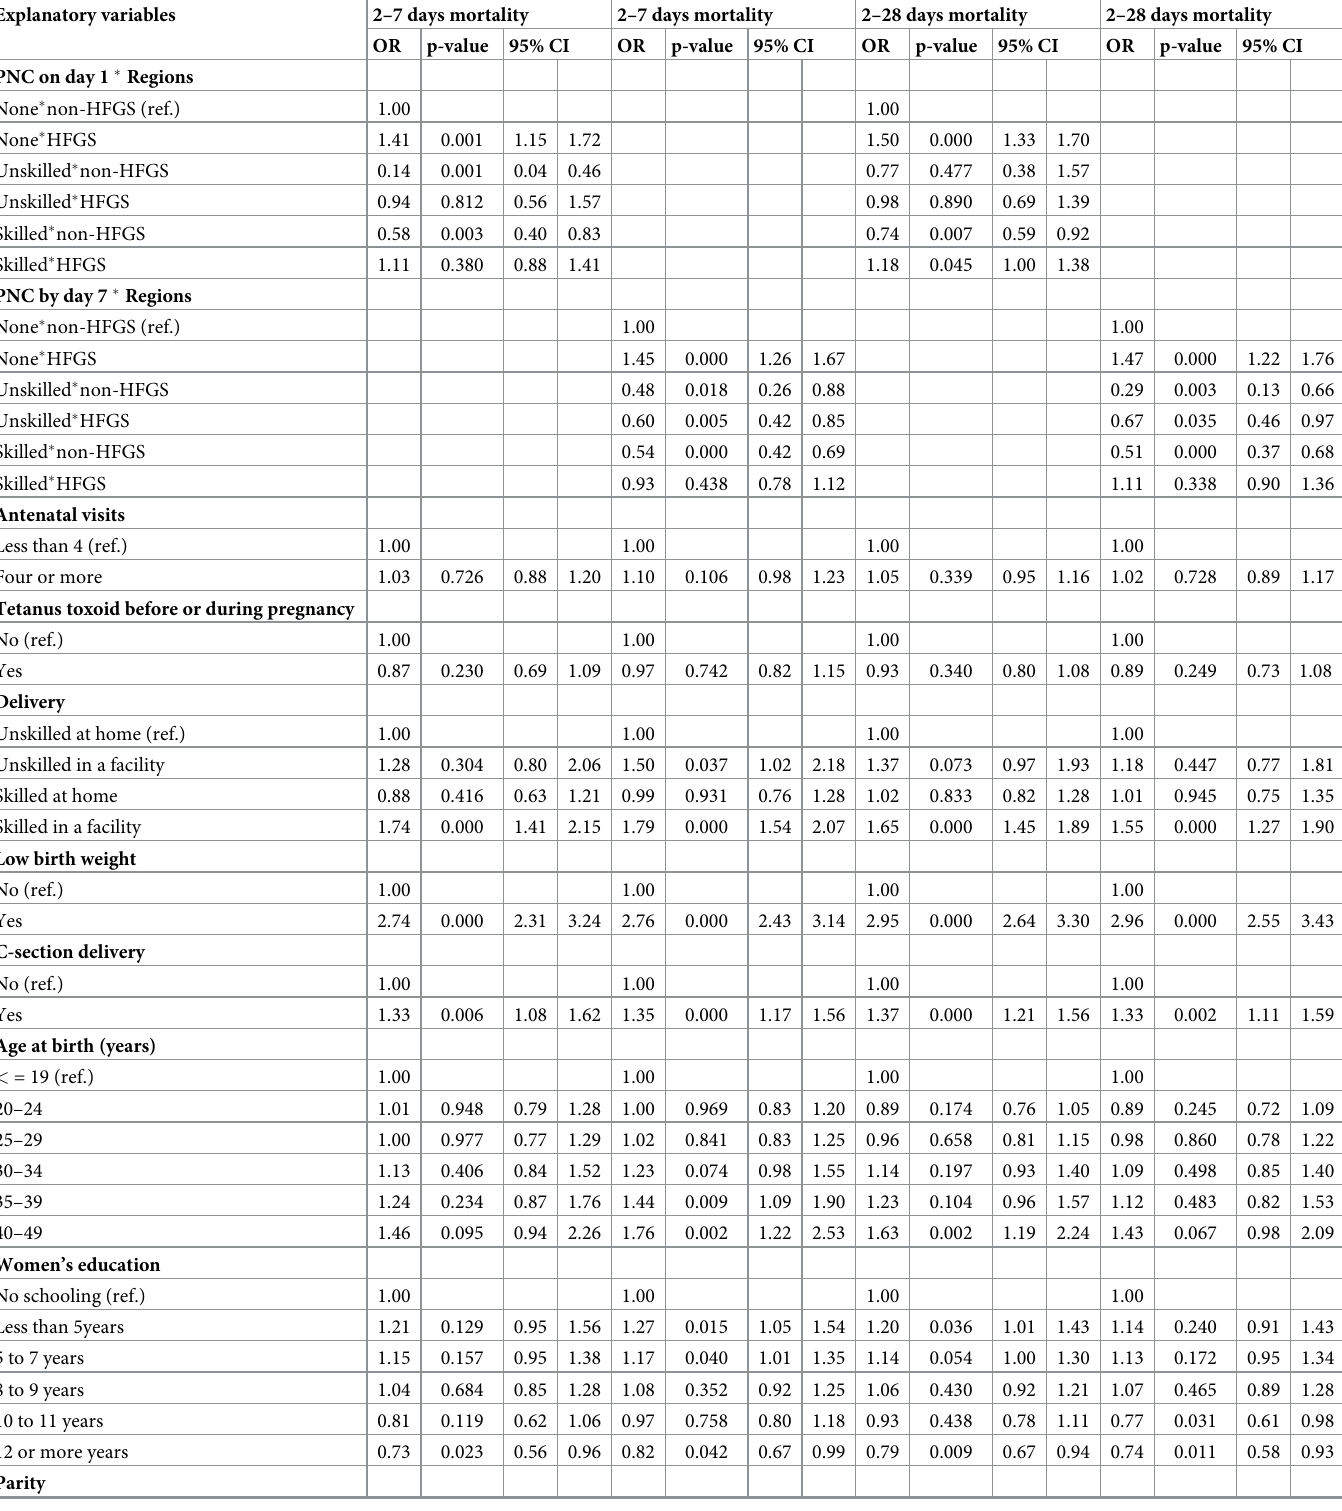
Table 5. Binary weighted logistic regression models showing interaction effect between PNC and regions on child deaths, India